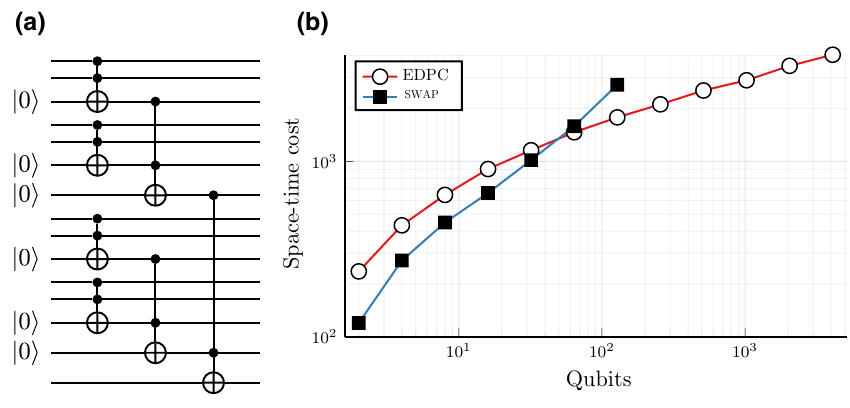
FIG. 13. We compare the space-time cost of compiling a T -gate optimized cir- cuit decomposition for a half C k NOT gate to the surface code using EDPC and SWAP compilation. We see in the log-log plot (b) that dependence of the space-time cost on n gives a higher scaling dependence in the case of SWAP compilation than